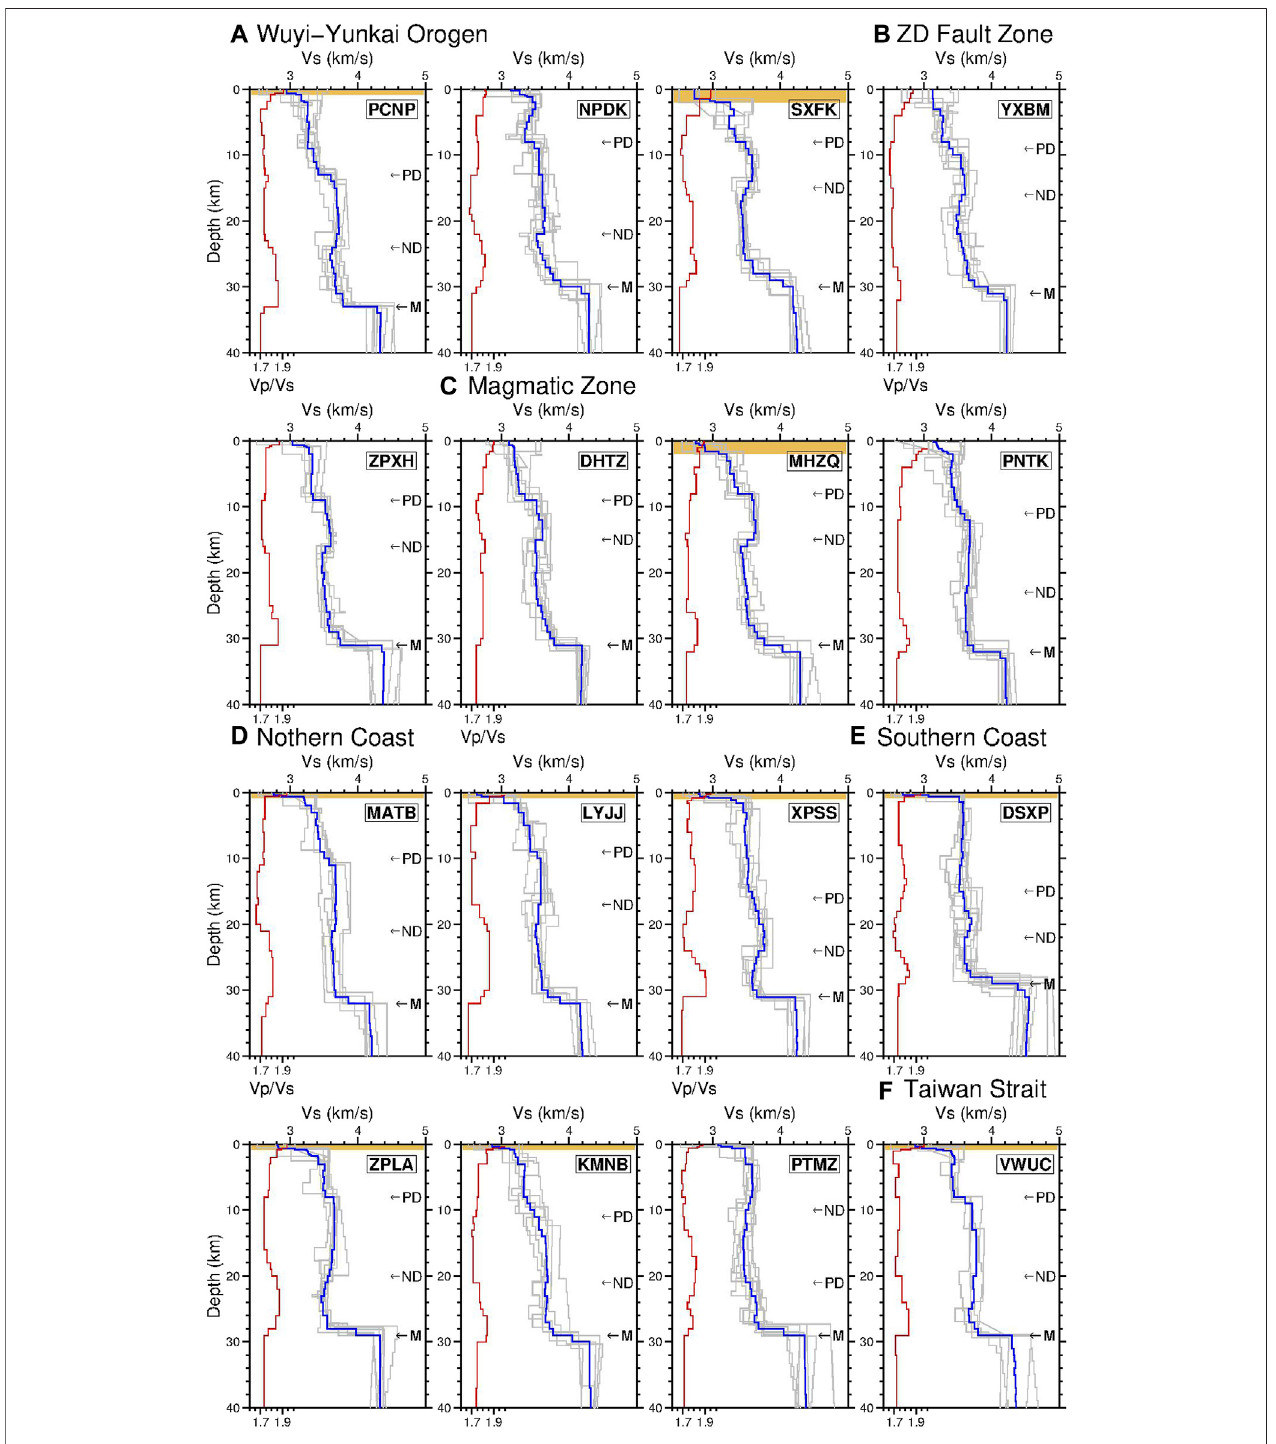
FIGURE6| Layeredshear-wavevelocity(Vs)structureofthecrustbeneatheachstation(exceptforYDFS)arrangedaccordingtoitsgeologicalsetting,fromwestto east, (A) Wuyi-Yunkai orogen, (B) Zhenghe-Dapu(ZD) suturezone, (C) Magmatic zone, (D) Northern Fujian coasts, (E) Southern Fujian coasts, and (F) WesternTaiwan Strait.TheoptimalVsandVp/Vsmodelsdenotedbyblueandredlines,respectively,areobtainedbyaveragingallthebest- fi tmodels(graylines)fromtheNAinversionof individual P RF stacks with the ray paths sampling the crust around each station. The sedimentary layer is highlighted as brown-colored shades. The Moho and intracrustal positive and negative discontinuities are identi fi ed and marked by M, PD, and ND, respectively. Note the higher velocity upper crustal layer in the coastal region and a shallower ND beneath SXFK, YXBM, ZPXH, DHTZ, and MHZQ.